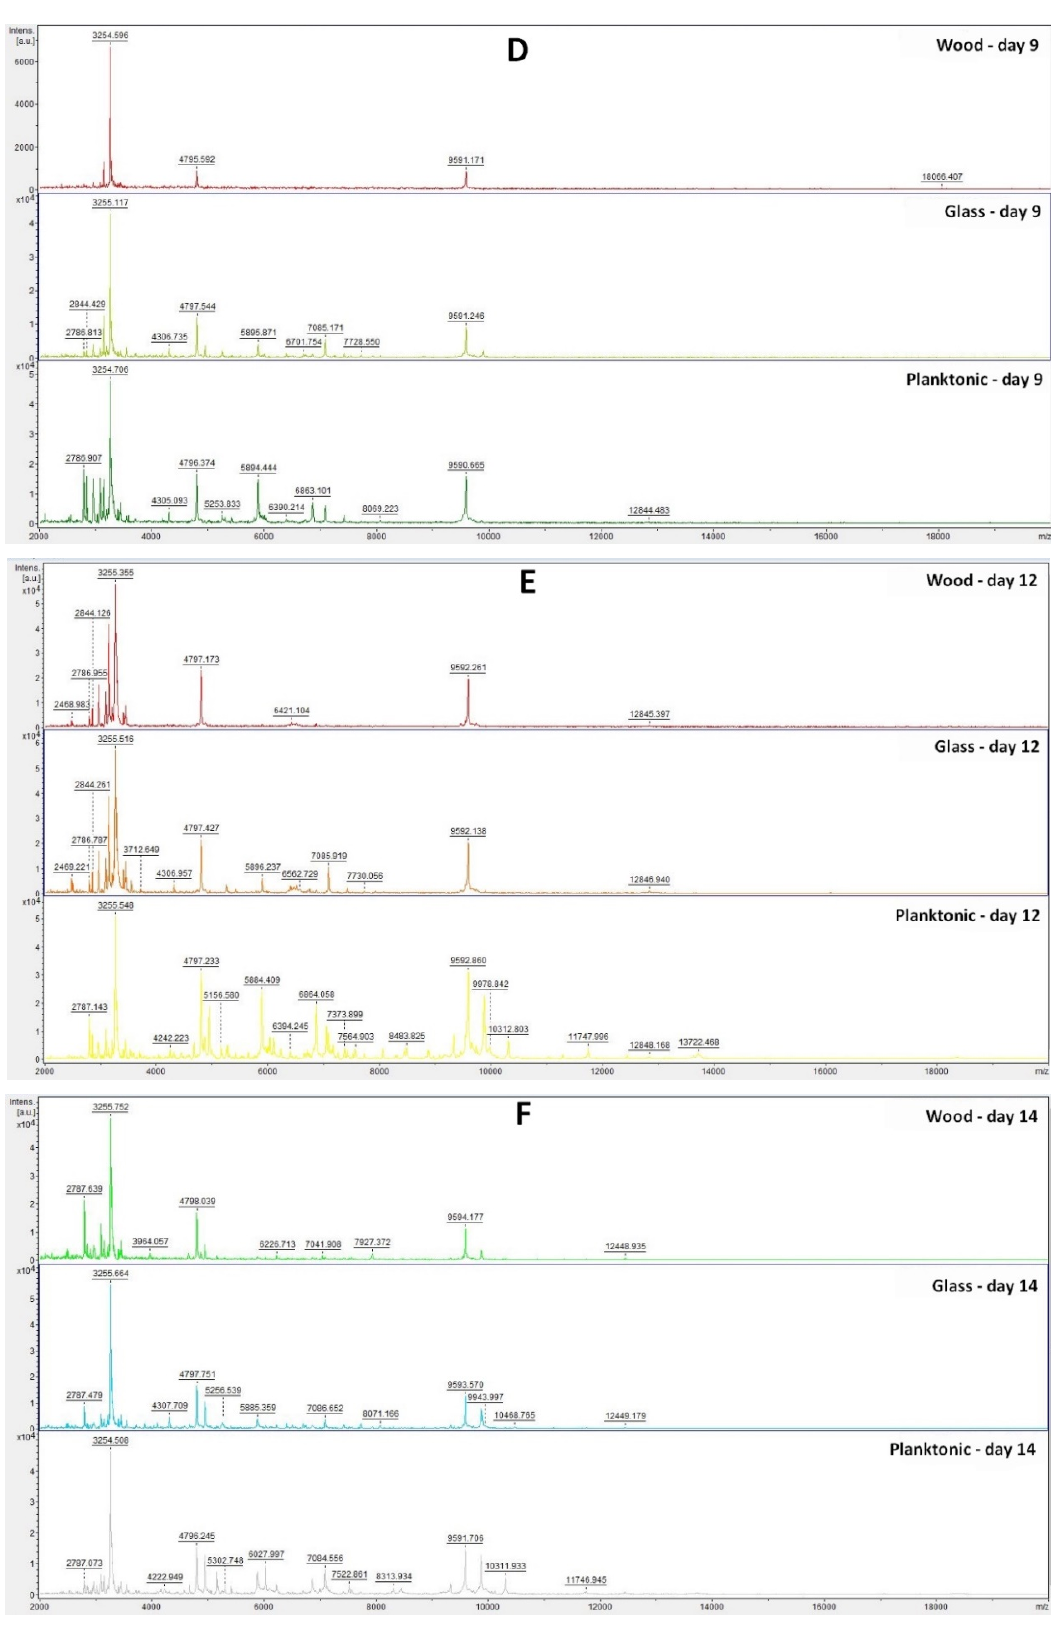
Figure 1. MALDI-TOF mass spectra of P. fluorescens biofilm development after TTEO exposition: